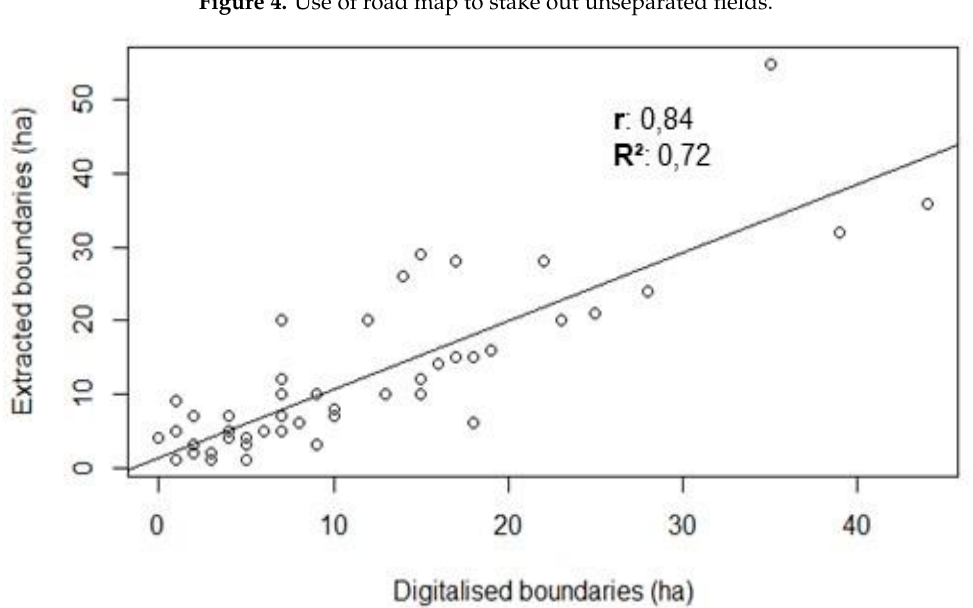
Figure 5. Positive correlation between extracted and digitalized field boundaries.